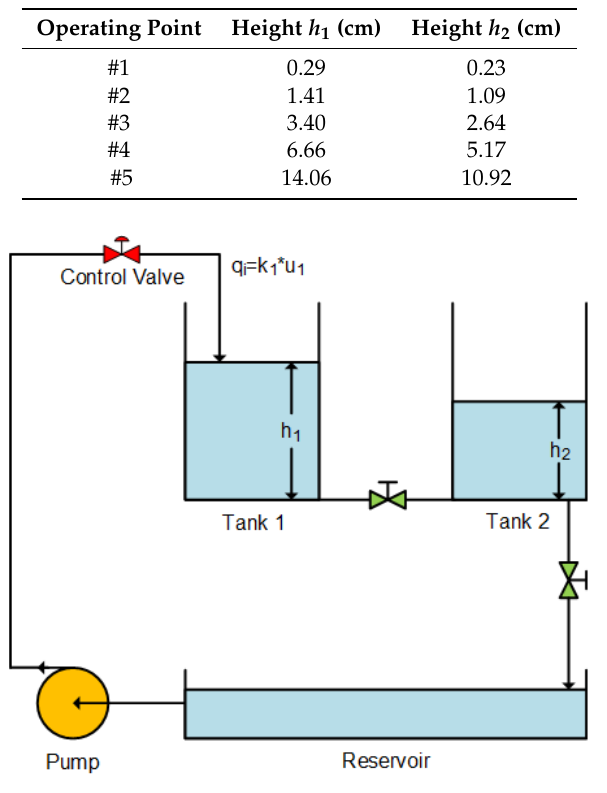
Figure 10. Illustration of the two interactive tanks